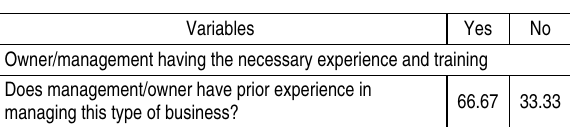
Table 4. Summary of managerial skills of